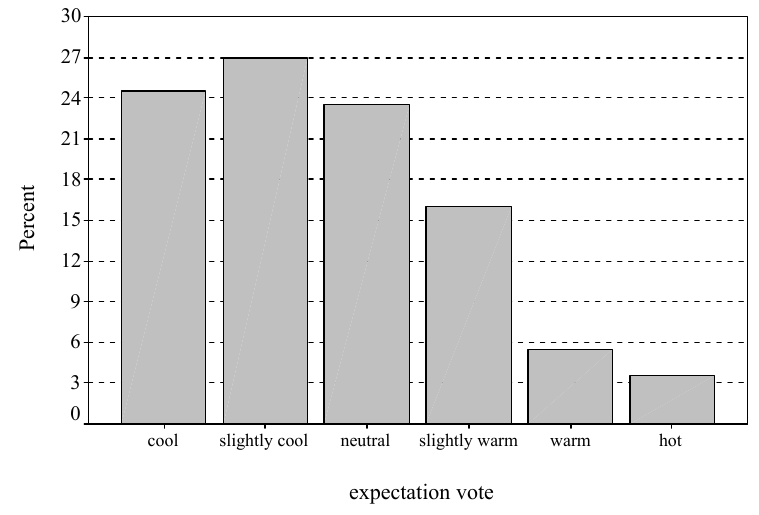
Figure 9. Southern Europe atrium expectation votes in the warm